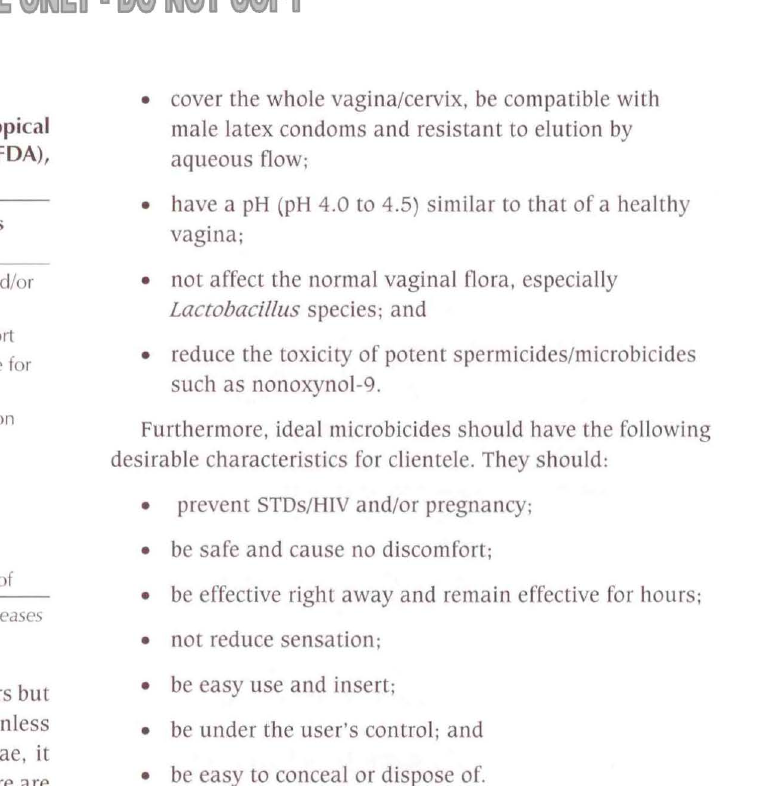
Important key and desired characteristics of ideal topical microbicides for the Food and Drug Administration (FDA), National Institutes of Health (NIH) and